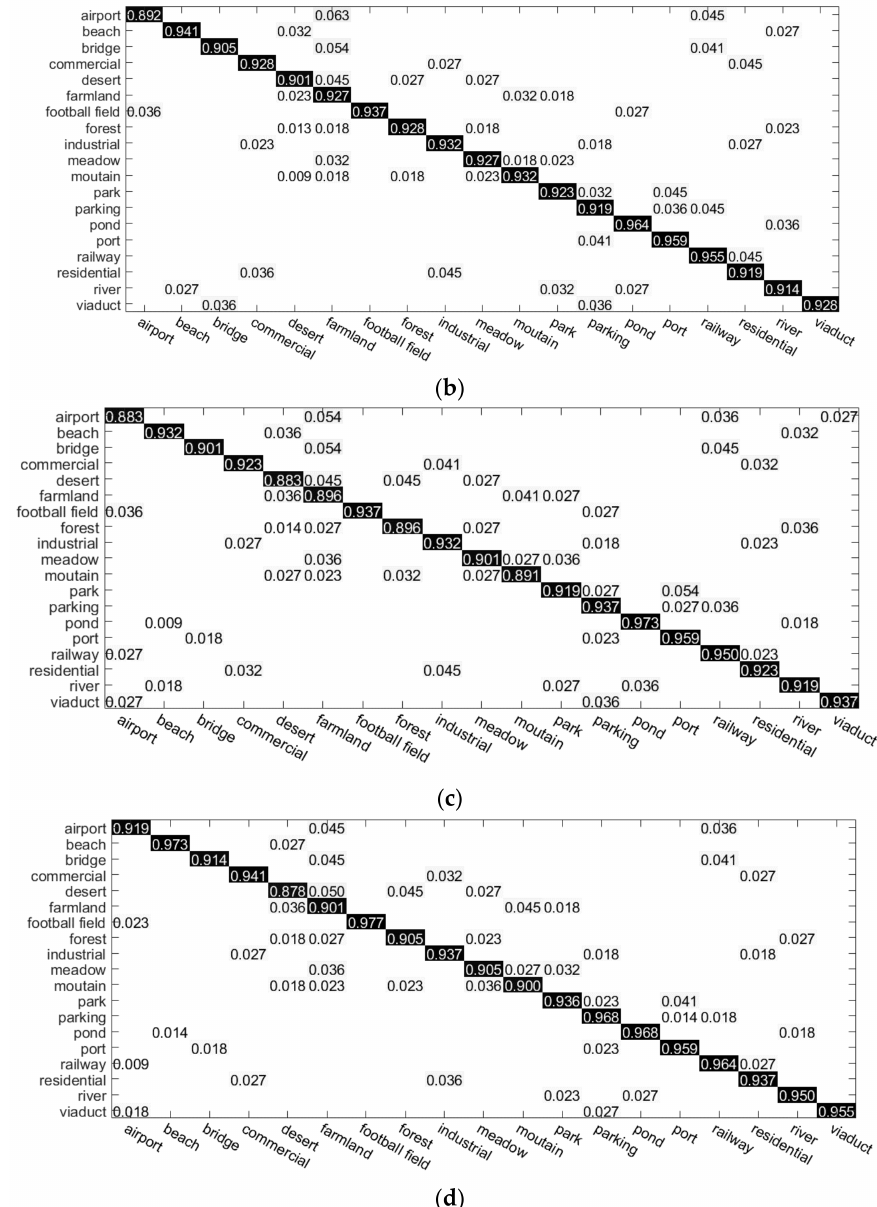
Figure 13. The confusion matrix for different methods in Table 3. ( a ) Color-boosted saliency-guided rotation invariant BOVW representation with parameter transfer method; ( b ) only without CBGCSRD method ( c ) only without rotation invariant BOVW representation; and ( d ) only without transferring SVM parameters from the source to the target